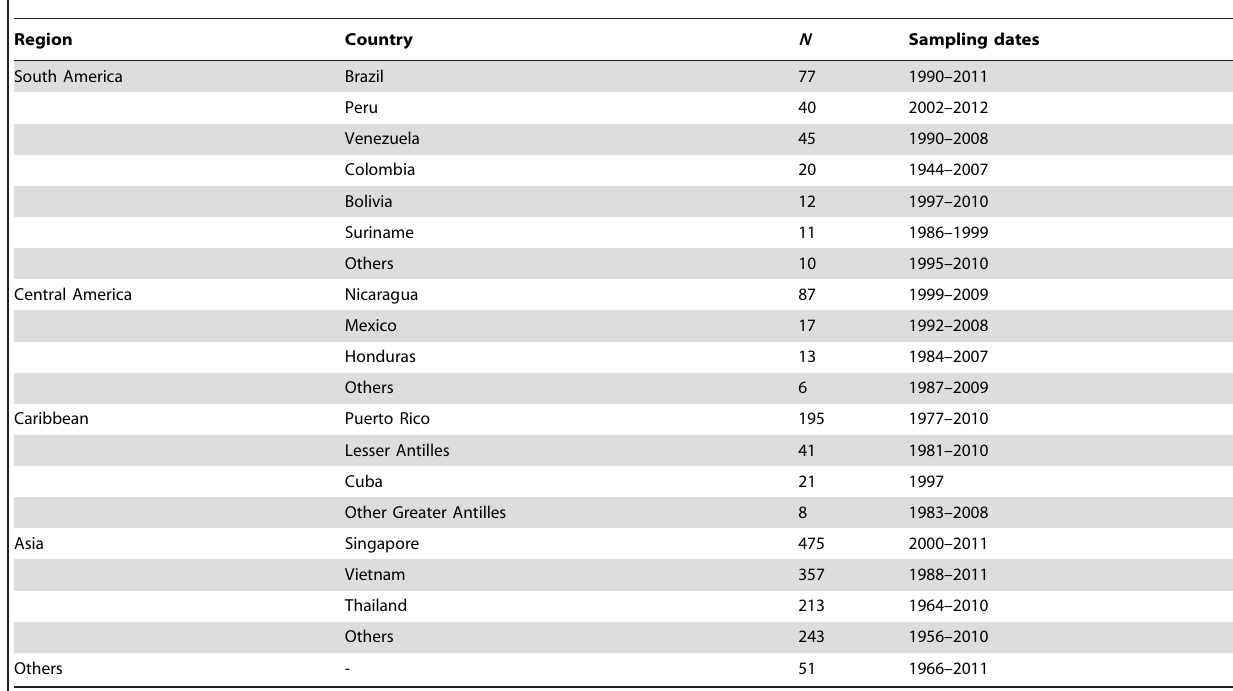
Table 1. Global DENV-2 data set.